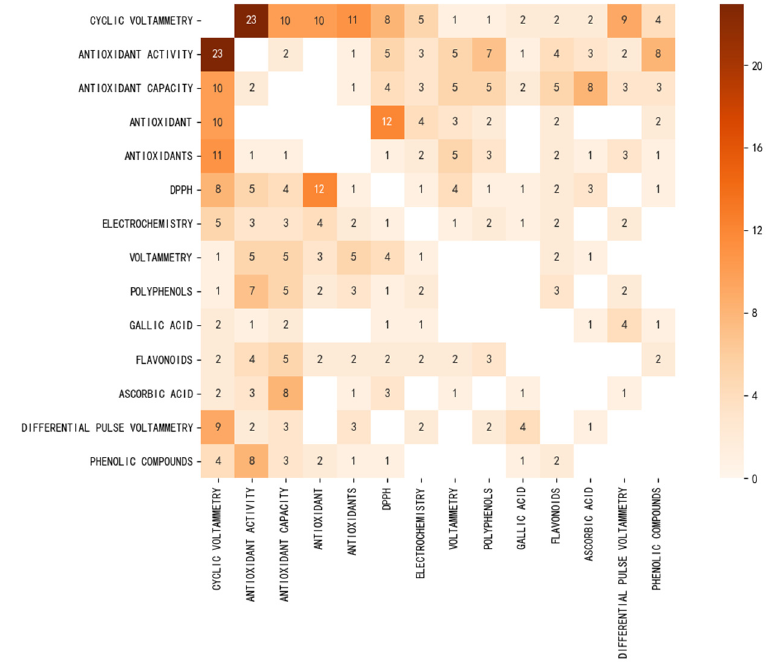
Figure 9. Keywords confusion matrix for the evaluation of antioxidants using electrochemical sen-